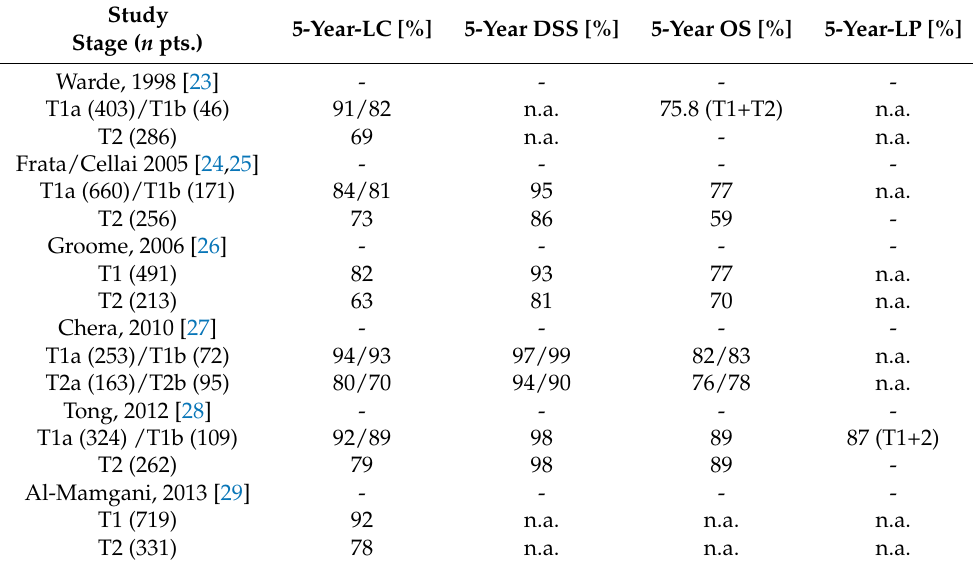
Table 6. Oncological outcome after pRT in T1 and T2 glottic cancer